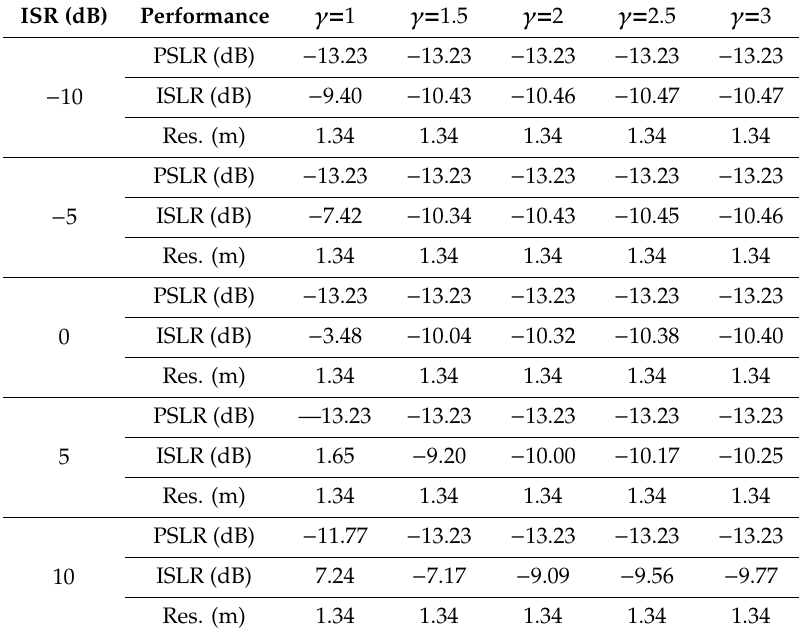
Figure 6. Simulation results of γ = 1 and γ = 2. ( a ) The recovered spectrum of γ = 1; ( b ) the pulse compression result of ( a ); ( c ) the recovered spectrum of γ = 2; ( d ) the pulse compression result of ( c ). Moreover, imaging performances including resolution (Res.), PSLR and ISLR after the RSIAA with di ff erent broadening factors are measured and summarized in Table 5. According to the measured parameters listed in Table 5, PSLR and resolution are almost the same, but ISLR is significantly a ff ected by the broadening factor. Commonly, the high ISLR level would lead to an increased noisy background in the focused SAR image. Table 5. The measured performances after the removed spectrum iterative adaptive approach (RSIAA) with different broadening factors. ISR (dB)